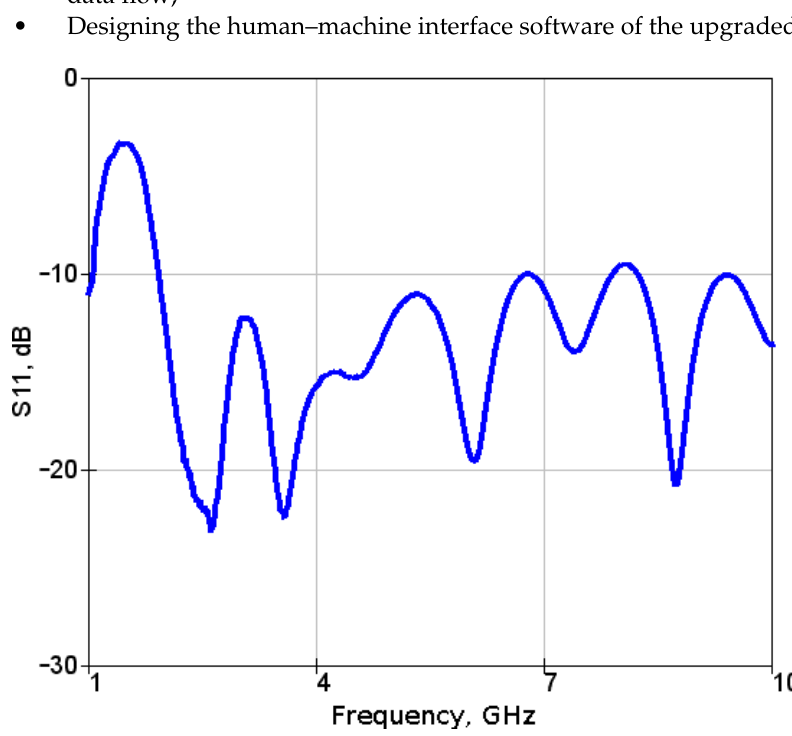
Figure 2. Measured S11 of the developed wideband antenna.